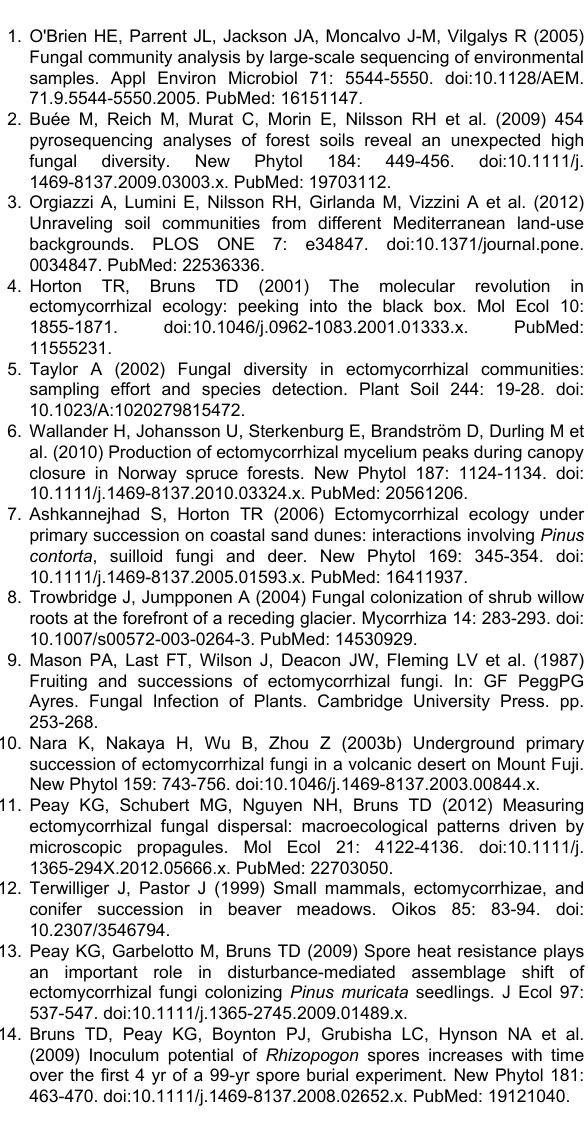
Table S2. Representative sequences for all fungal OTUs.